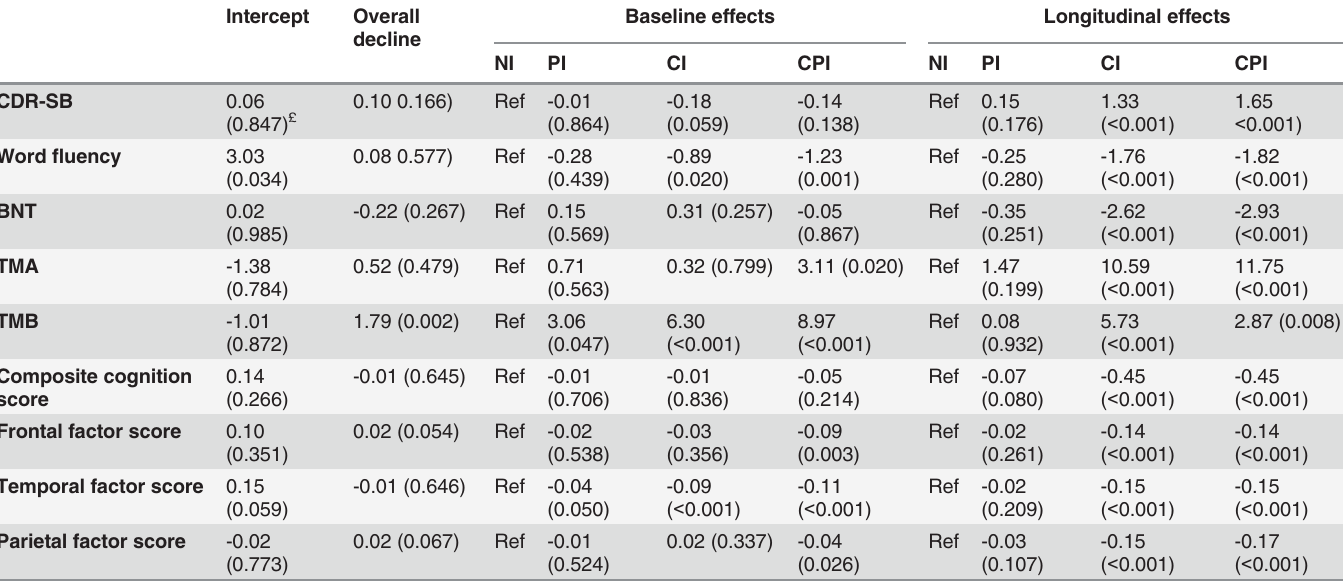
Table 3. Rate of decline in cognitive performance by baseline impairment status (full models